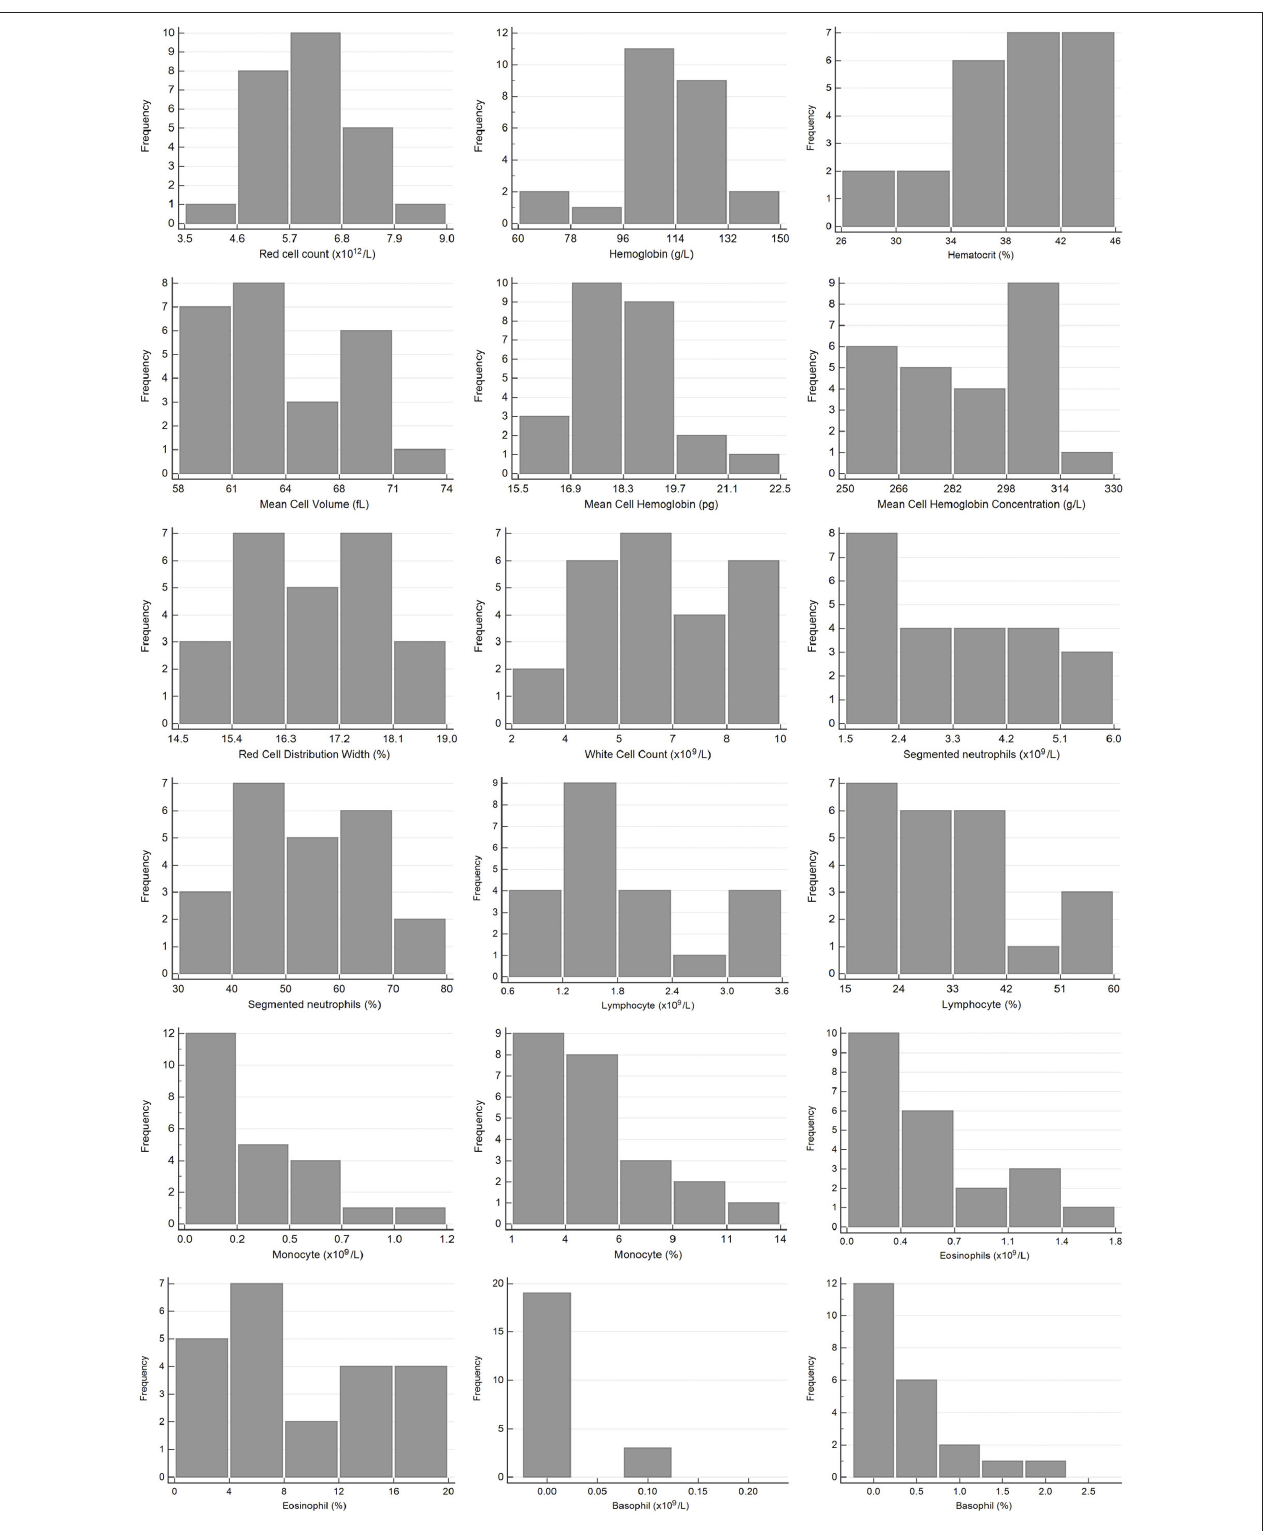
FIGURE 1 | Histograms showing the distribution of results for hematology measurands from Temminck’s pangolin for the Abaxis Vetscan HM5 and manual differential leukocyte counts. The x-axis represents the measurand result; the y-axis represents the frequency of these values occurring.